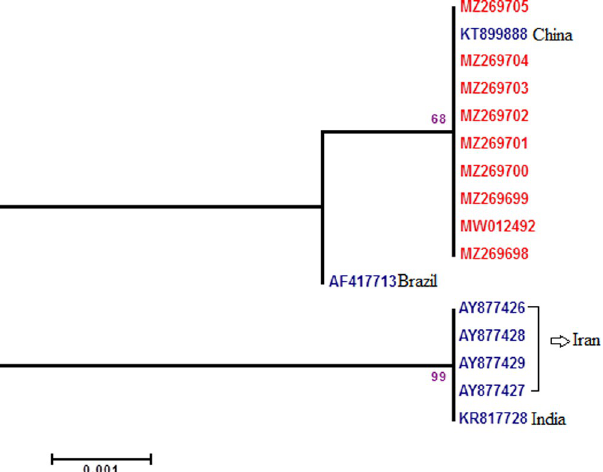
Fig 2. Phylogeny of COI sequence from lab strain. Bootstrap values > 70 shown at nodes. Nodes without numbers had a value < 70. Final ML Optimization Likelihood: -1252.592081.